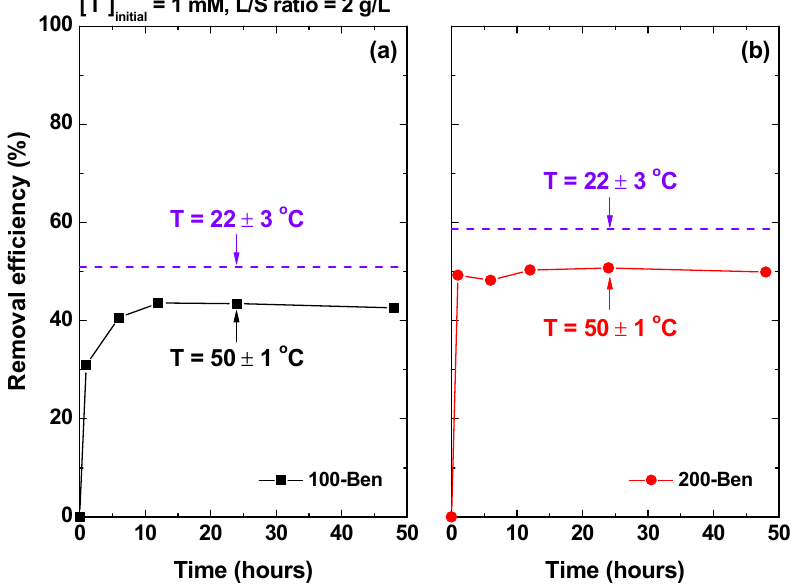
Figure 4. Removal efficiencies of ( a ) 100-Ben and ( b ) 200-Ben for iodide determined at T = 50 ◦ C. Dashed line indicates efficiencies obtained at room temperature for